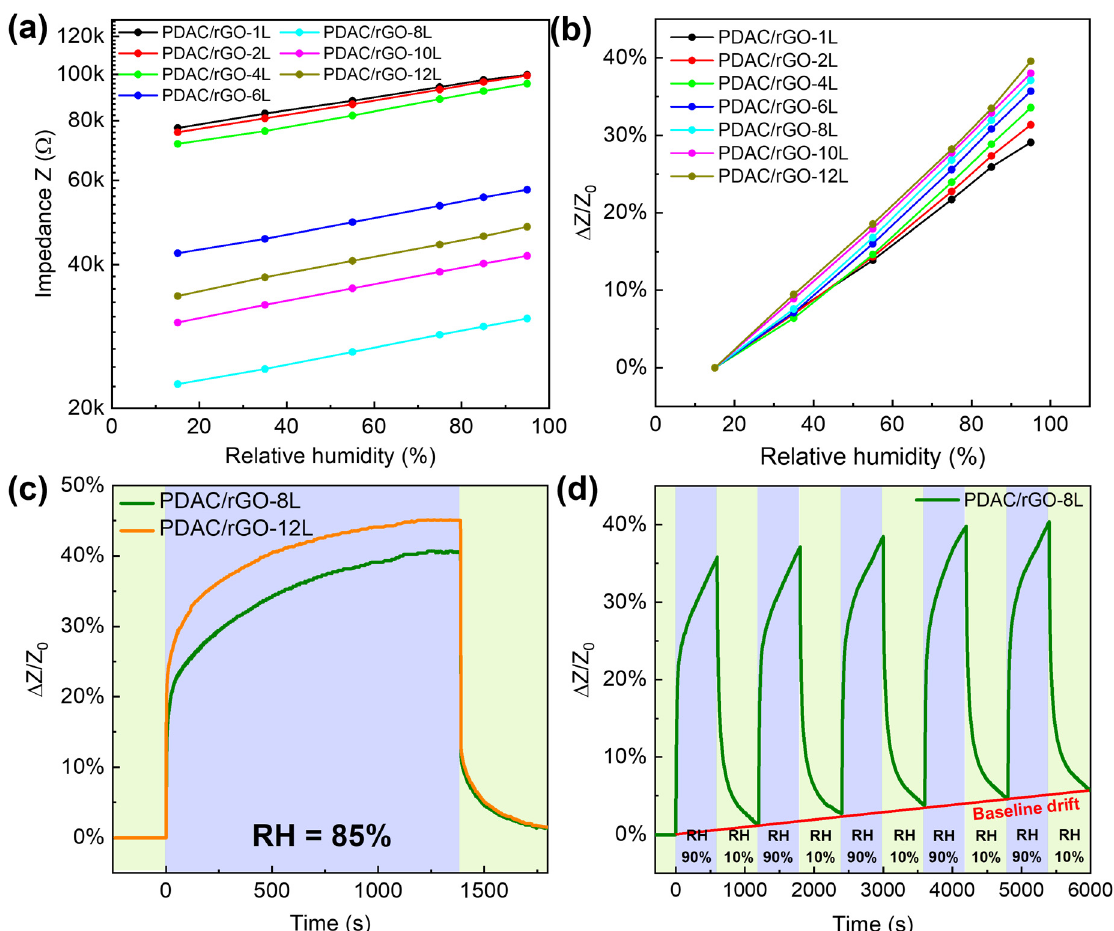
Figure 4. Static and dynamic characteristics of PDAC/rGO humidity sensors: ( a ) Impedance of PDAC/rGO sensors; ( b ) sensitivity of PDAC/rGO sensors; ( c ) response curves of PDAC/rGO-8L and PDAC/rGO-12L sensors; ( d ) repeatability of the humidity characteristic of PDAC/rGO-8L sensor.